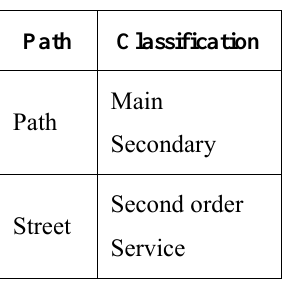
Table 2: Paths and main streets